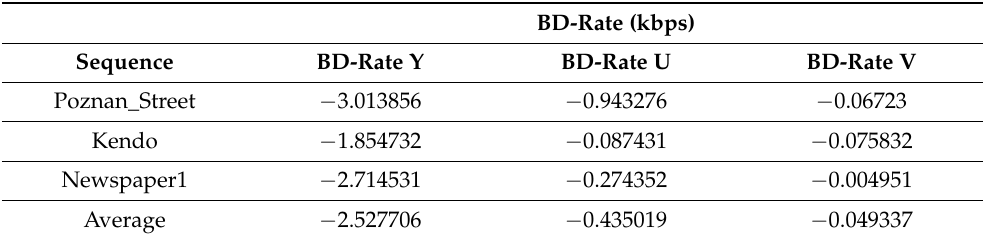
Table 5. BD-Rate of the proposed single-layered multiview video codec with respect to the anchor MV-HEVC